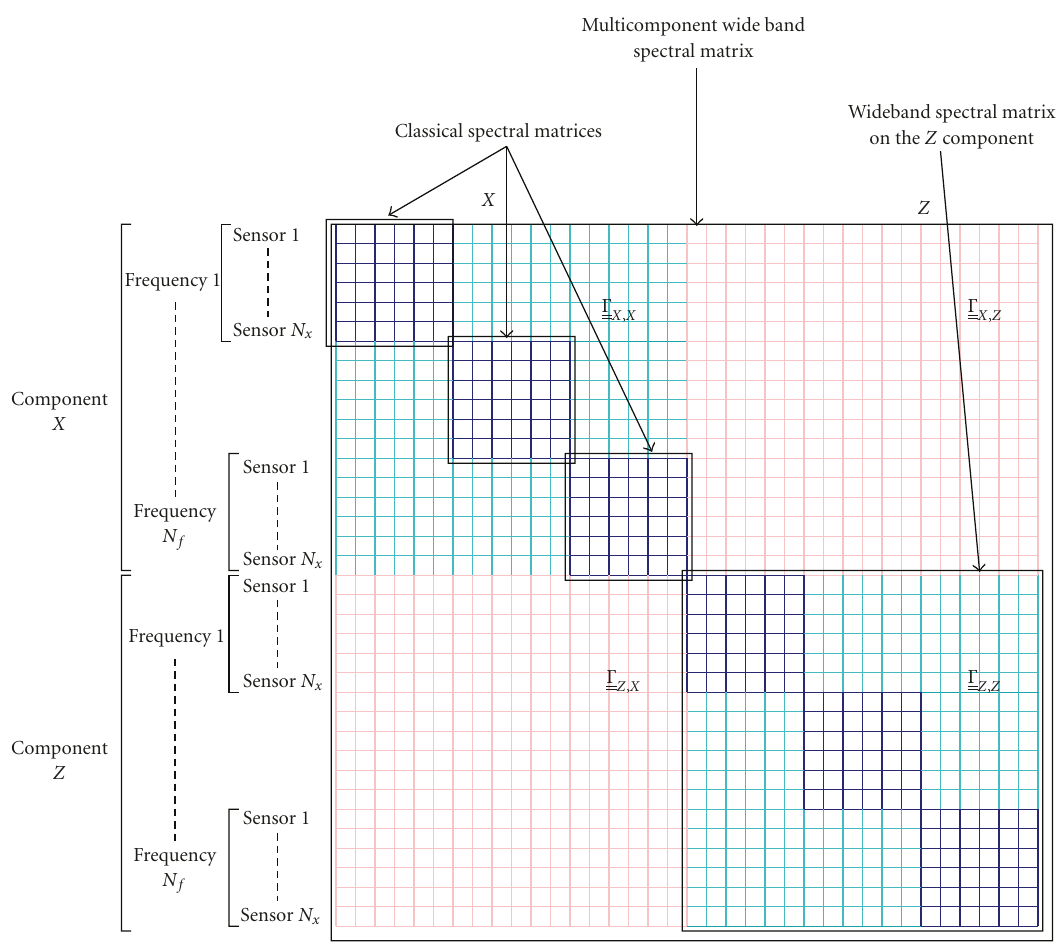
Figure 1: Diagram of a 2-Component wideband spectral matrix showing in red the cross-component matrices, in blue the inner-component matrices, and in black each classical spectral matrices defined at each frequency